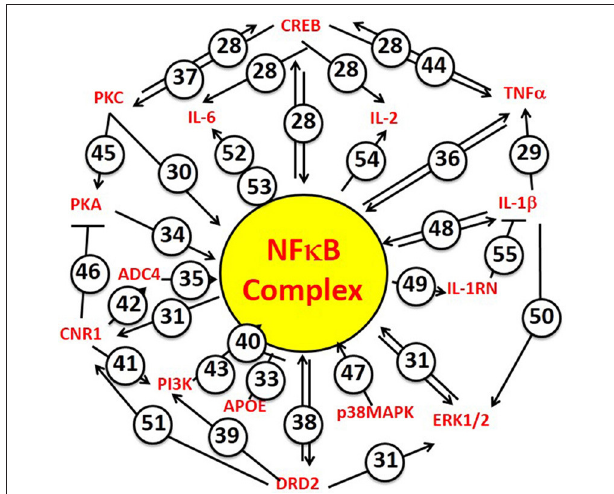
FIGURE 7 | NFkB Complex is the focus of principal hubs for PTSD and CVD risk genes. The NFkB Complex is identified specifically by the IPA algorithm to include the cytosolic inhibitors [NF κ B, p105] and [I κ B α ], and the driver [NF κ B, p65]. Numbers attached to each arrow are example references from the experimental literature, which document activator functions (arrows) or inhibitor functions (T-endings) between genes. Many of the NFkB-driven genes also interact with each other. When making predictions regarding mechanism, the IPA algorithm takes these interactions into account by reference to its “master” network of information from the Ingenuity Knowledge Base. The numbers correspond to the following references. 28. Wang et